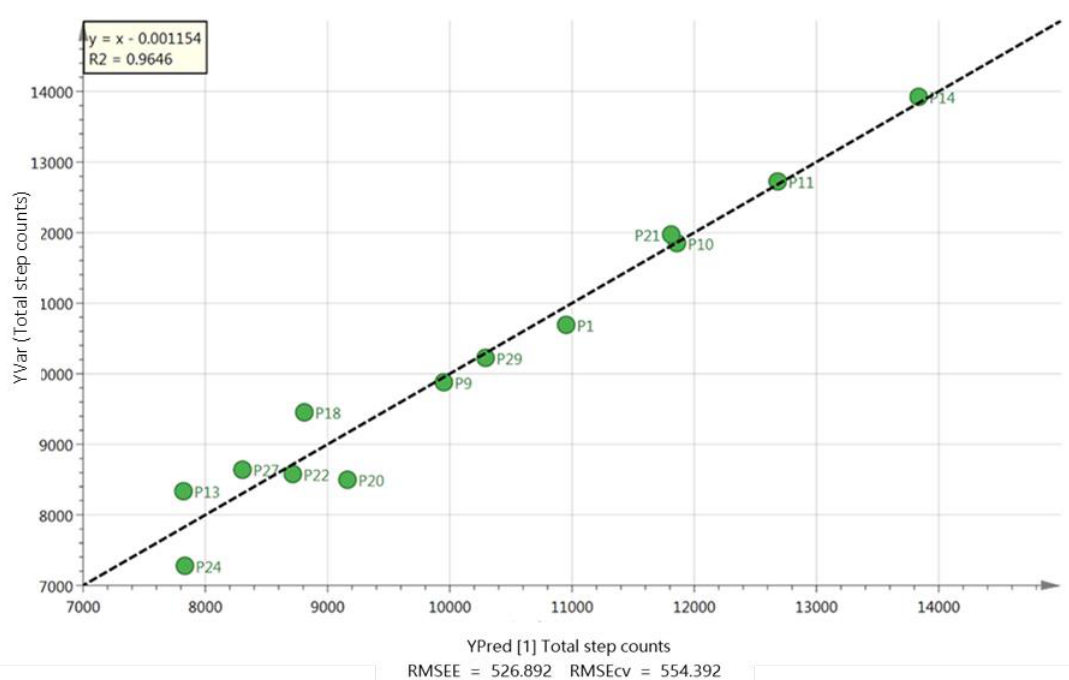
Figure 7. Correlation between total step counts and fatty acids for white European participants based on six fatty acids, palmitoleic, linoleic, arachidate, laurate, erucate and